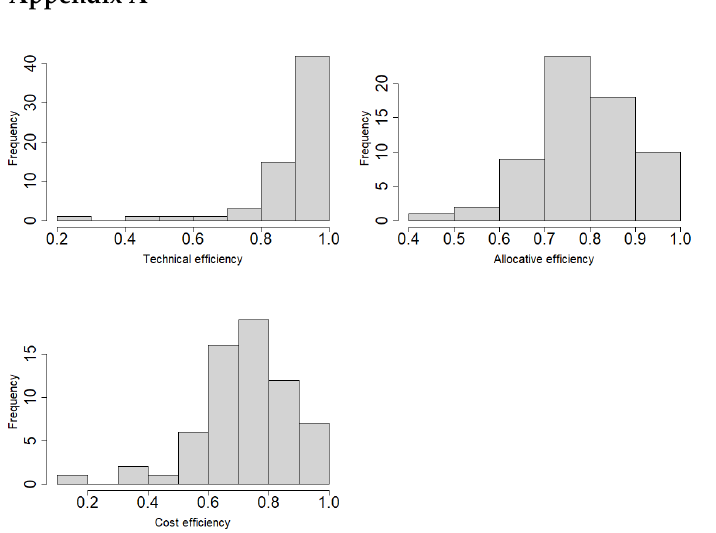
Figure A1. Efficiency distribution for sampled